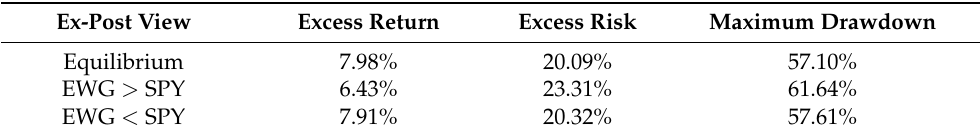
Table 2. Performance of Static Confidence